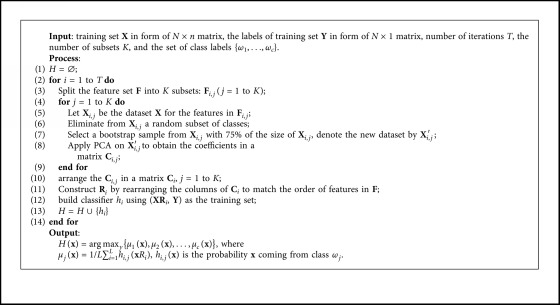
 Rotation Forest.